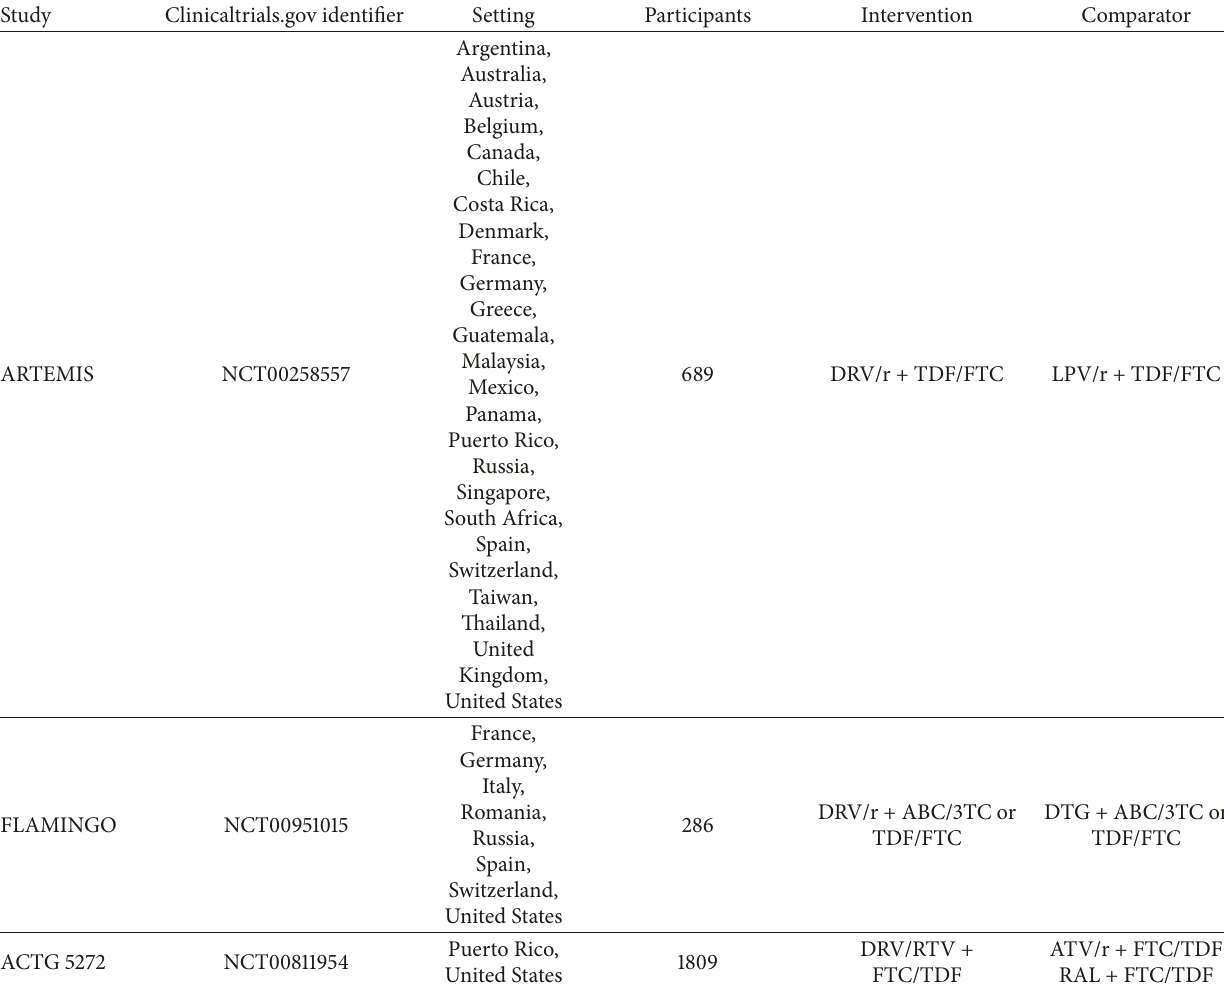
Table 1: Characteristics of included